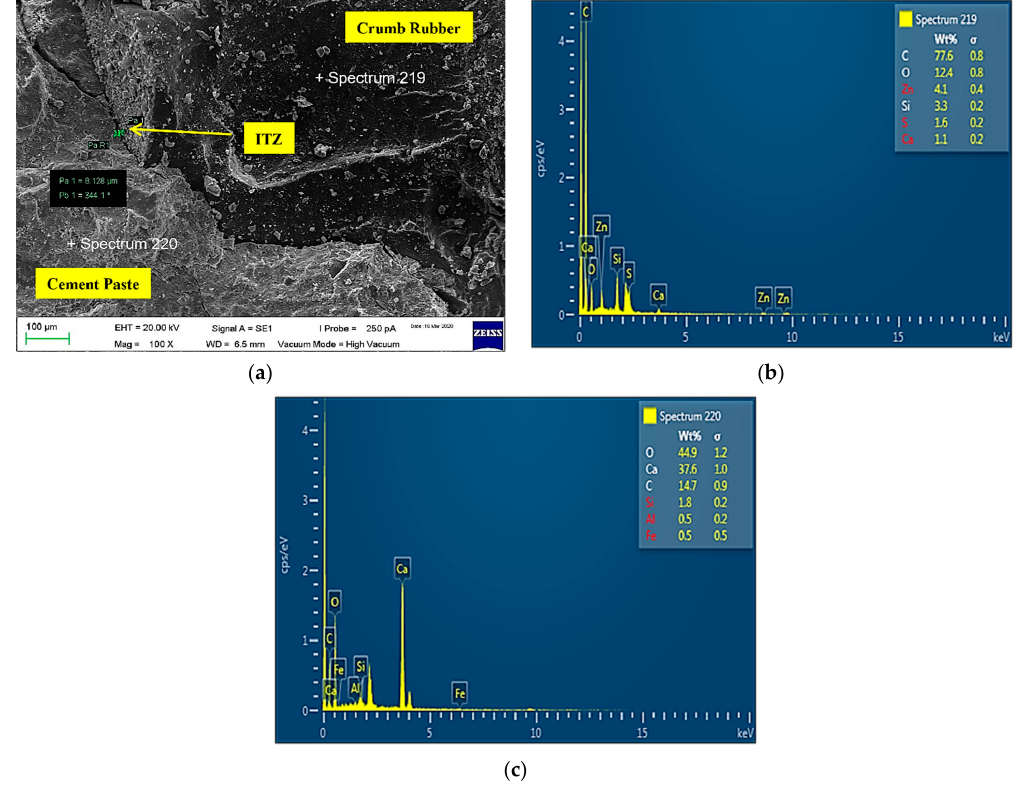
Figure 18. CR7.5-NS5 sample. ( a ) Microstructure ITZ = 8.128 μ m; ( b ) EDX of crumb rubber; ( c ) EDX of cement.